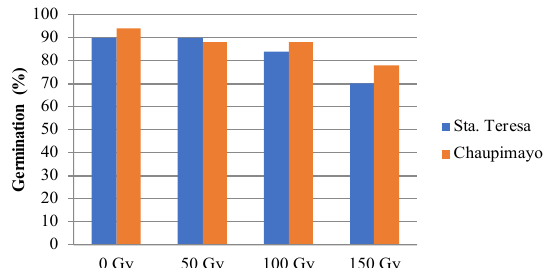
Figure 1. Percentage of germination of coffee ( Coffea arabica L. var. typica) seeds originating from Santa Teresa and Chaupimayo under laboratory conditions at 62 days after sowing following irradiation with gamma rays at 0 (control), 50, 100, and 150 Gy.